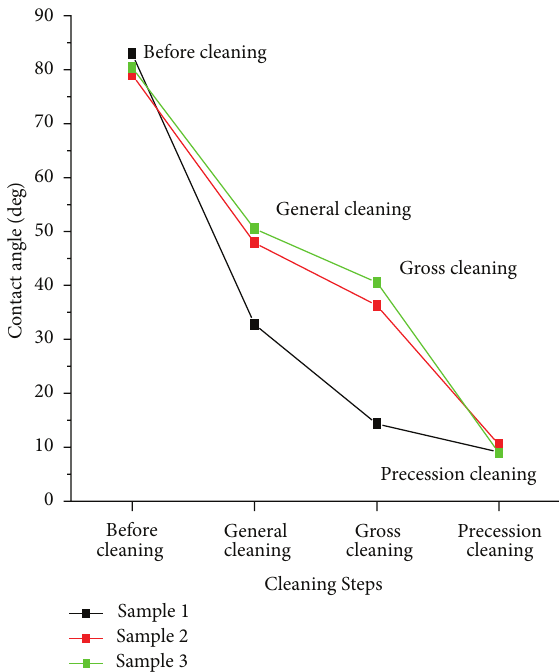
Figure 4: Curves of contact angle versus processing steps.